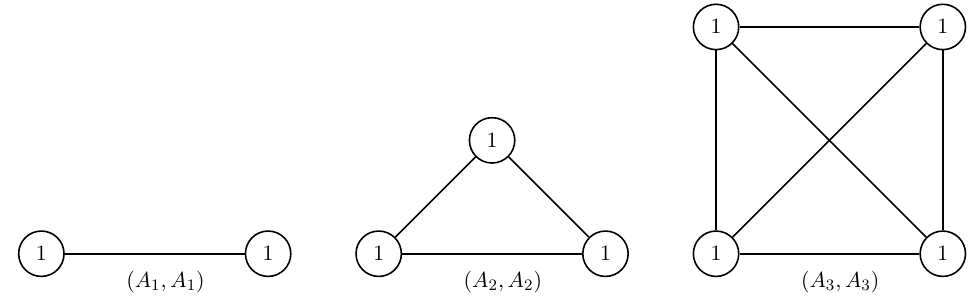
) theories, with s = 1 , 2 , 3 , and Figure 30 . 3d mirrors from class S construction for ( A s , A ( s +1) p − 1 p = 1 . For a given s , the 3d mirror for generic p is given by the same quiver diagram with every pair of gauge nodes being connected by p lines. The gauge group is obtained by factoring out an overall U(1) , which can be implemented by ungauging any one of the U(1) gauge